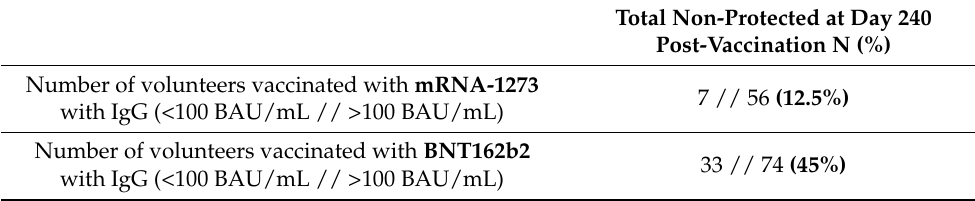
Total Non-Protected at Day 240 Post-Vaccination N (%) 7 // 56 (12.5%) 33 // 74 (45%)